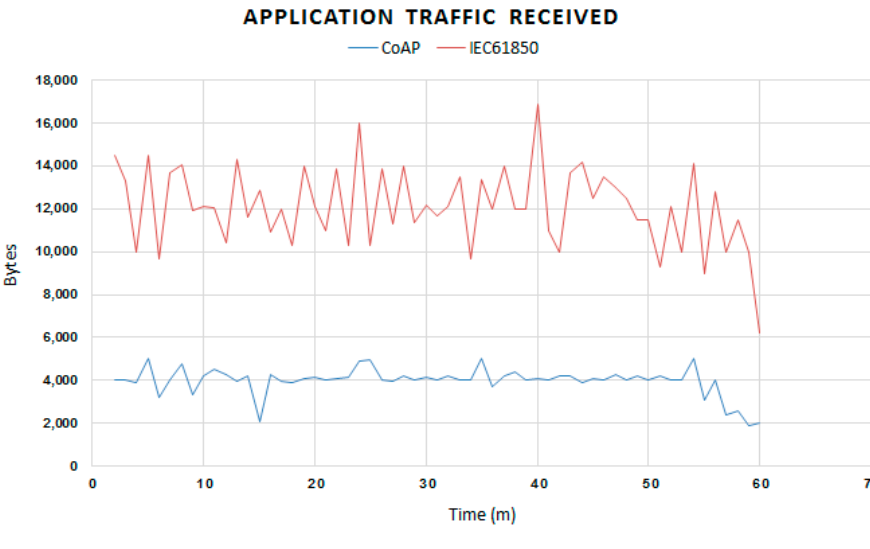
Figure 11. Application traffic received.